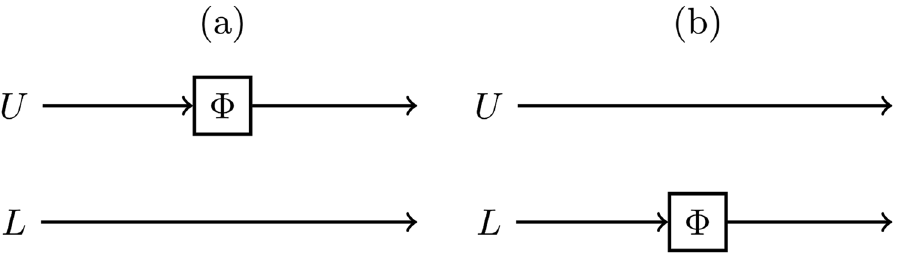
Figure 1. Visualization of different noise locations. Alice sends a two-qubit system to Bob. Qubits U and L are transmitted through the upper and lower path, respectively. In ( a ) and ( b ) the local noise influences the qubit U and L ,